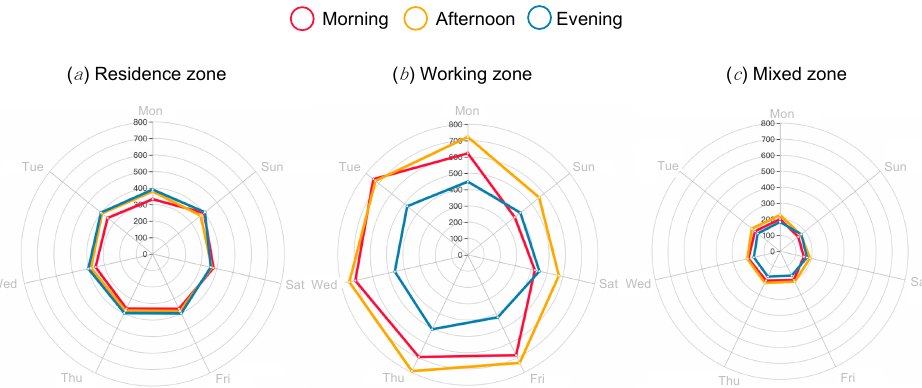
Figure 7. The number of parked vehicles in ( a ) the residence zone, ( b ) the working zone, and ( c ) the mixed zone in the morning, afternoon and evening on every day of the week. Each colored line in the subfigure represents a time period, i.e., the morning (red line), the afternoon (orange line), or the evening (blue line). The circles stand for a week, which is equally divided into 7 parts representing Monday to